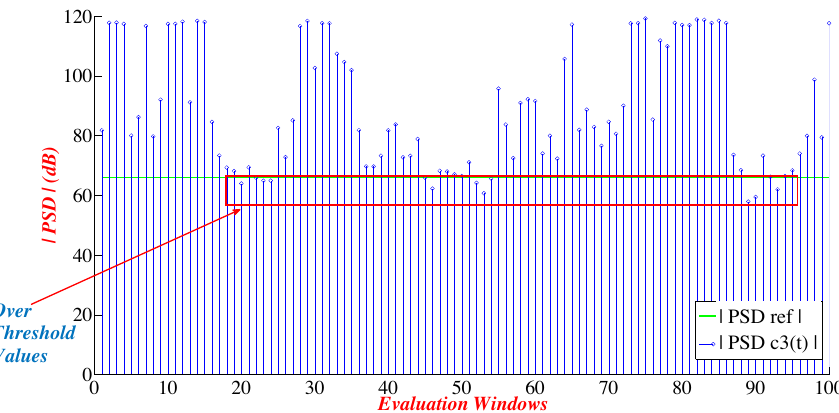
Figure 7. Comparison between PSD frame and PSD ref for signal c 3 ( t )